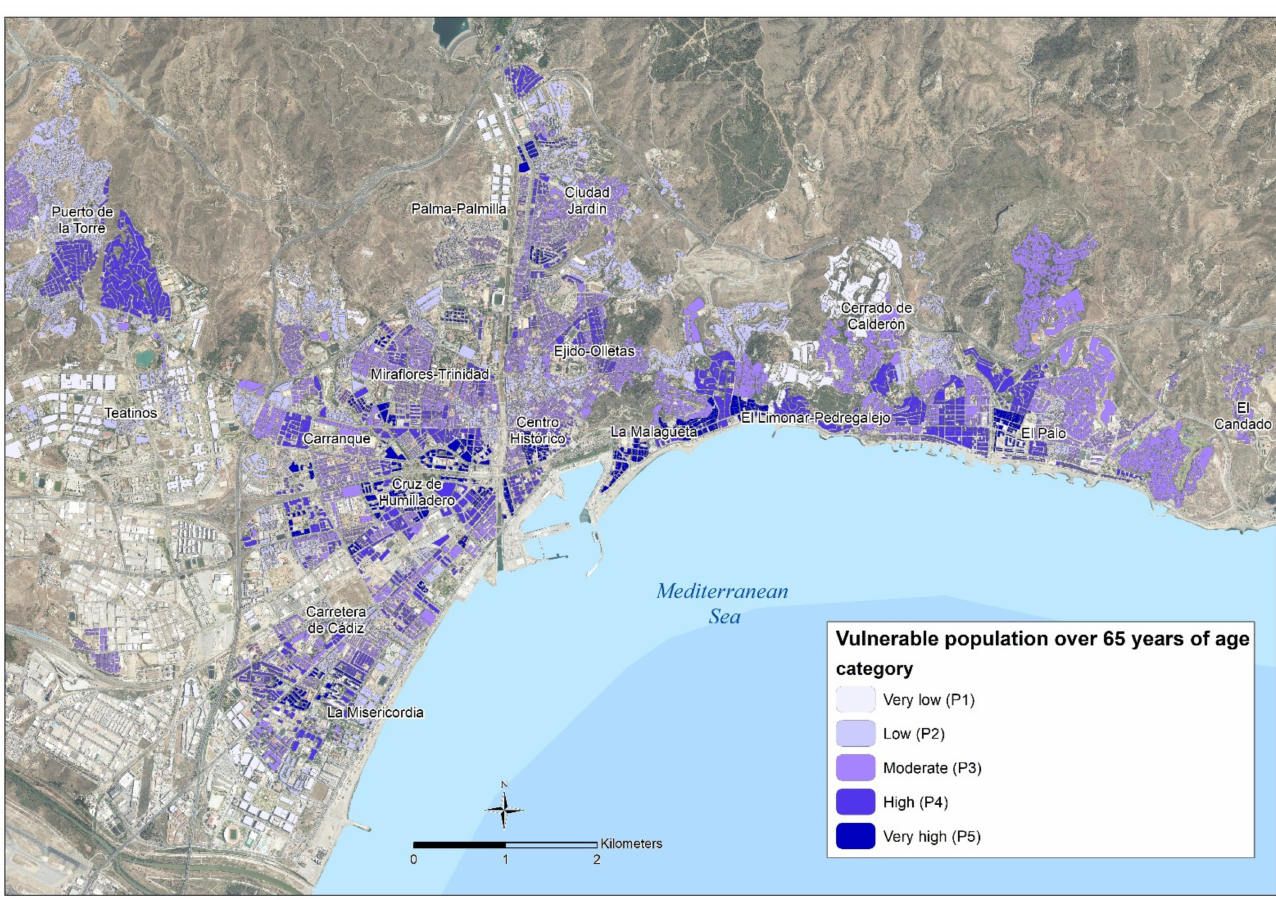
Figure 9. Map of the proportion of people older than 65 years per